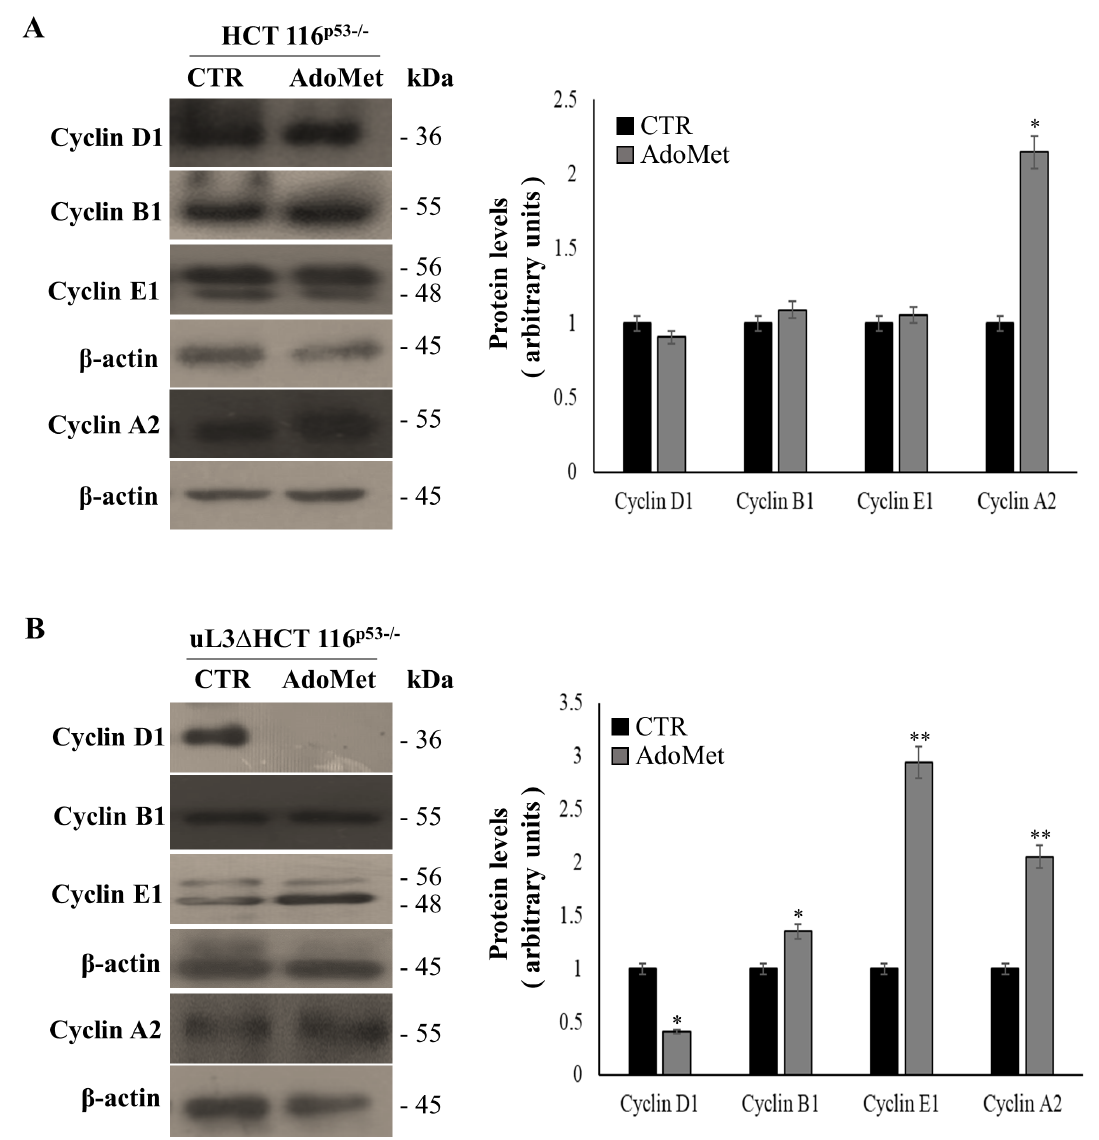
Figure 3. Effect of AdoMet on cell cycle regulatory proteins in HCT 116 p53 − / − and uL3 ∆ HCT 116 p53 − / − colon cancer cells. The level of cell cycle-regulatory proteins in HCT 116 p53 − / − ( A ) and uL3 ∆ HCT 116 p53 − / − cells ( B ) was measured by western blot analysis. The housekeeping protein β -actin was used as a loading control. The relative densitometric analysis is reported in the corresponding graphs, expressed as arbitrary units. Bars represent the mean of triplicate experiments; error bars represent the standard deviation. * p < 0.05, ** p < 0.01 vs. untreated cells set at 1. The images are representative of three immunoblotting analyses obtained from three independent experiments. Full-length blots are shown in Figure S1.